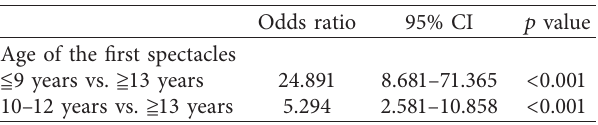
Table 5: Logistic regression analysis of the age of the first spectacles for high